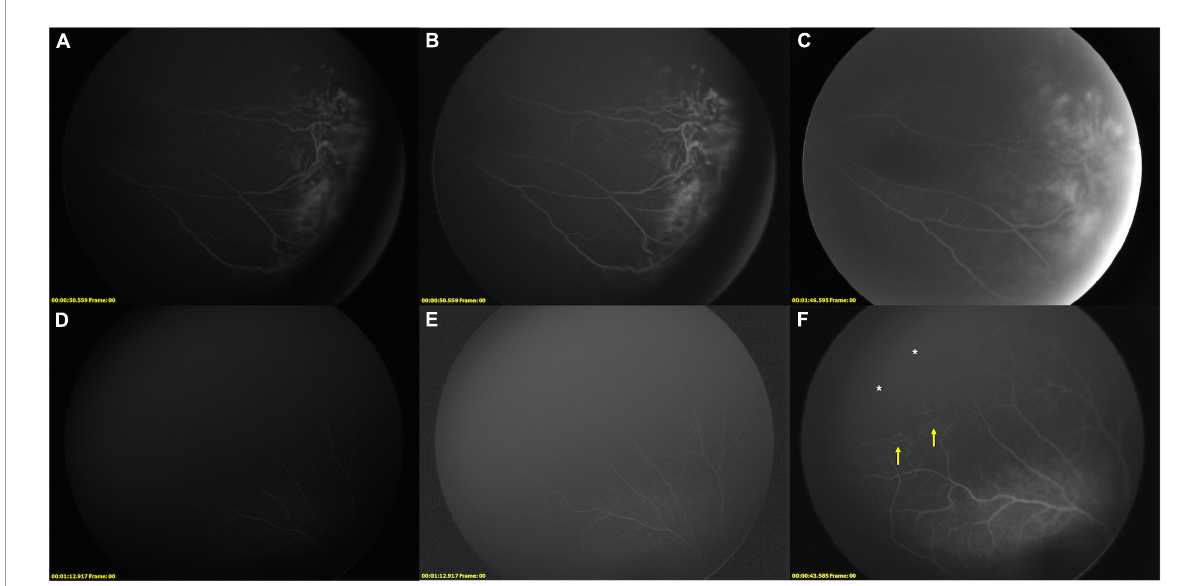
FIGURE3 Supplementary relaser in the fellow eye after RD-FFA. (A–F) FFA images of case 10, a 5-year-old girl with IP. (A,B) [ (B) : adjusted version of (A) ], LD-FFA (OS): showed dragged-disk, vessels dilatation, vessels tortuosity, messy vessels with fluorescein leakage, and peripheral avascular zone in the temporal field. C, RD-FFA (OS) showed dragged-disk, vessels dilatation, vessels tortuosity, messy vessels, fluorescein leakage, telangiectasis, peripheral avascular zone, and laser spots in the temporal field. (D,E) [ (E) : edited version of (D) ], LD-FFA (OD) was obscure and showed sparse posterior vessels. (F) RD-FFA (OD) showed vessels tortuosity and messy vessels in the periphery (yellow arrow) and peripheral avascular zone (white asterisk) in the superotemporal